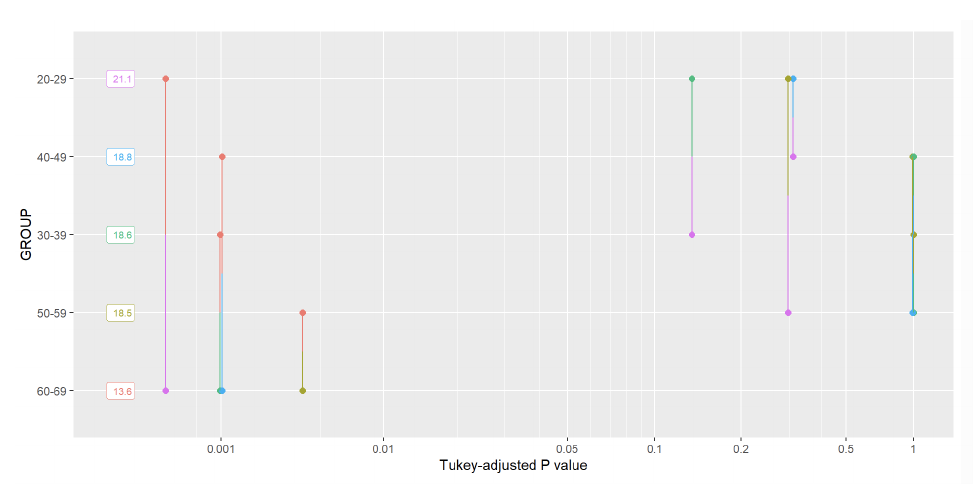
In Figure 6, Tukey analysis results for the multi-scale entropy were presented.